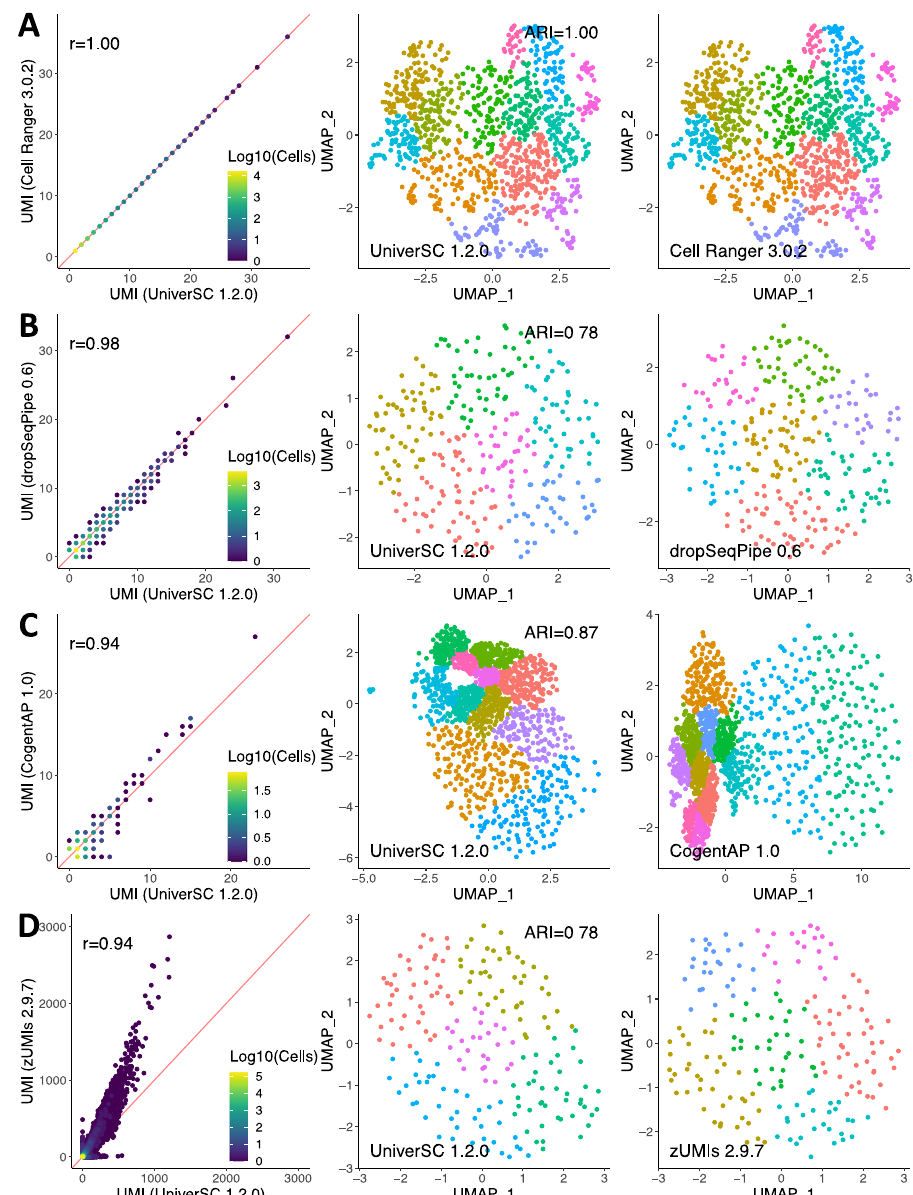
Fig.2|SimilarityassessmentofUniverSCagainstotherpipelines. Comparisons between pairs of GBMs generated by UniverSC 1.2.0 against Cell Ranger 3.0.2 ( A ), dropSeqPipe 0.6 ( B ), CogentAP 1.0 ( C ), and zUMIs 2.9.7 ( D ).Directcomparison of GBMs, i.e., comparison of UMI counts for each gene for each cell, is on the left column. When data points (cells) overlap, the extent of data points overlapping is